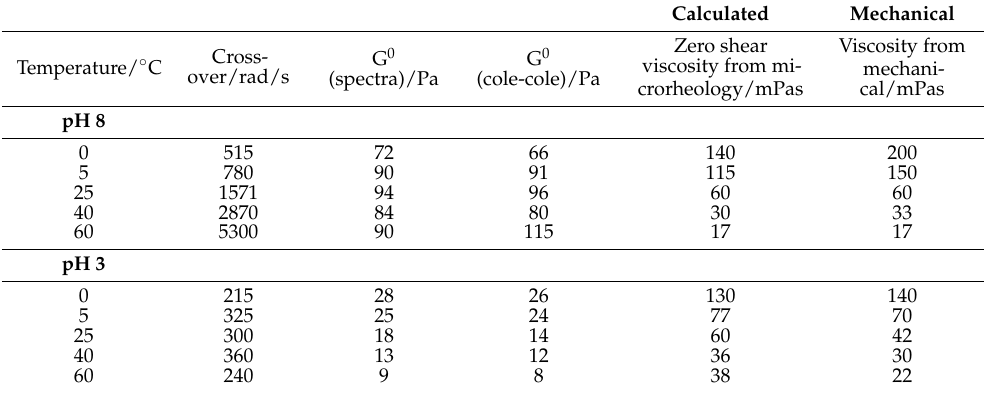
Calculated Mechanical